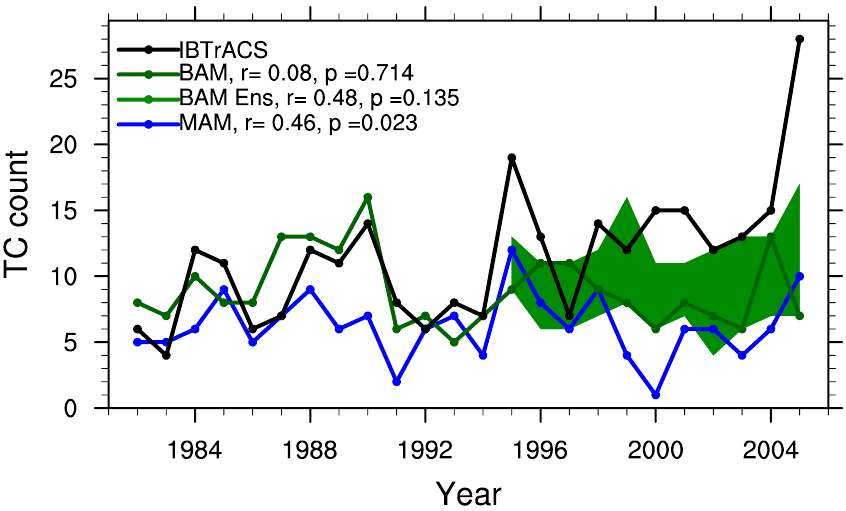
Figure 5. Interannual variability in North Atlantic TCs for IBTrACS, BAM, BAM ensemble (shaded), and MAM. The TC counts are calculated over the seasonal average (June – November) from 1982 to 2005. The correlation (r) and statistical significance ( p ) between the simulated TCs counts and IBTrACS are included in the legend.